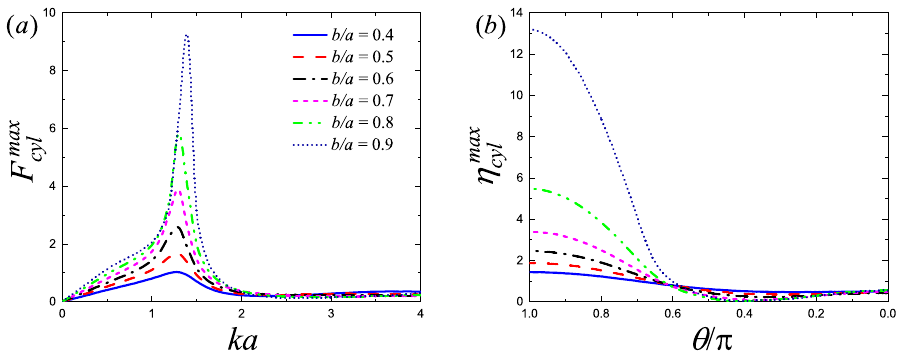
Figure 9. Variation in non-dimensional wave force and run-up on the interior cylinder for different b / a with β = π /3, h / a = 1, k x / k = 0.5, U 0 = 0.4 m/s, G = 0, α = 2 π /3, and γ = 2 π /3: ( a ) force; ( b ) run-up, ka = 1.4.